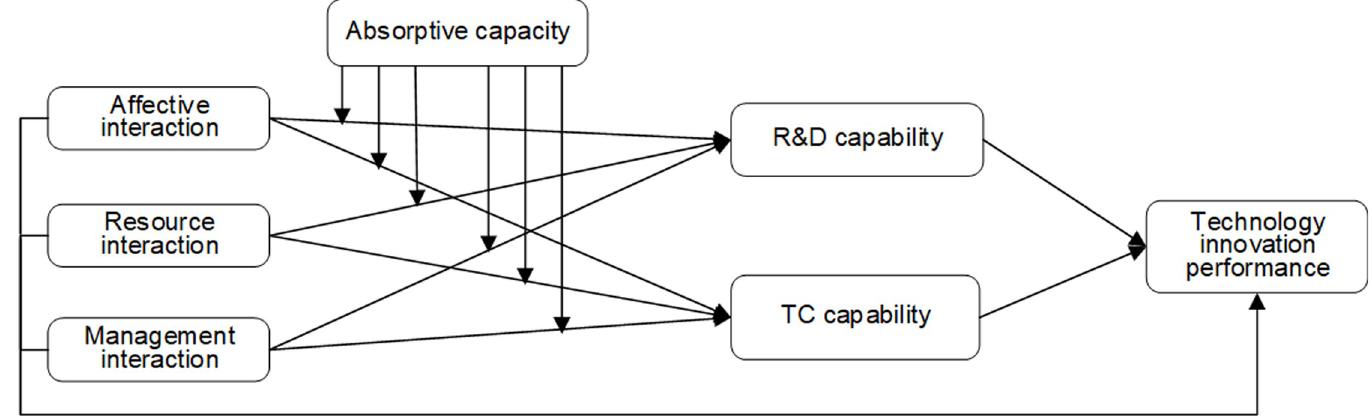
Fig 2. Conceptual